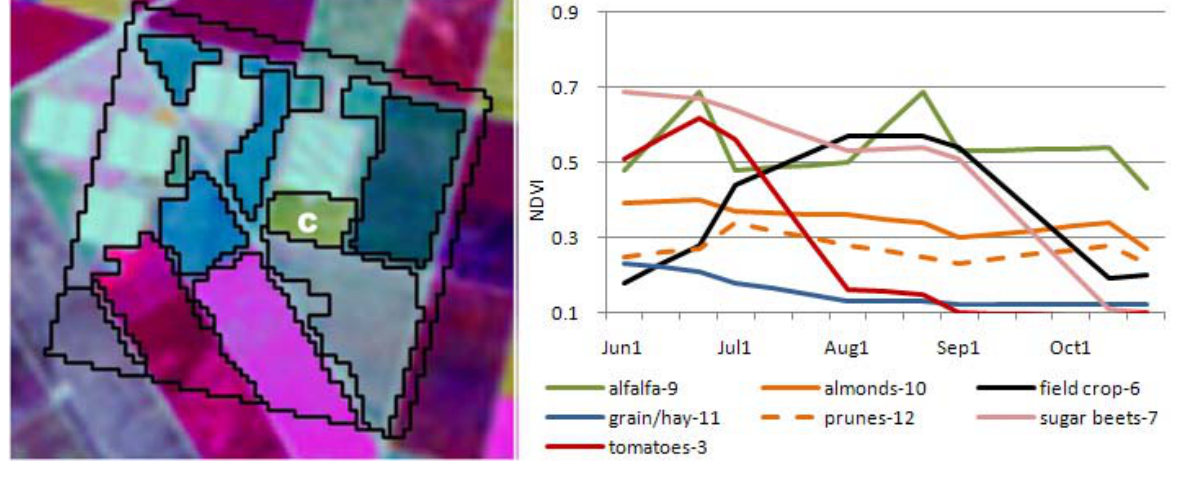
Figure 4. Landsat time series color composite image (PCA123) and NDVI time series plots for selected crop fields within Section 16S17E01. Paraquat was applied to one cotton field. The field with the closest match to cotton is identified as a white “C” on the image to the left and black line in the graph on the right. Identification of the specific field sprayed with paraquat was possible in this